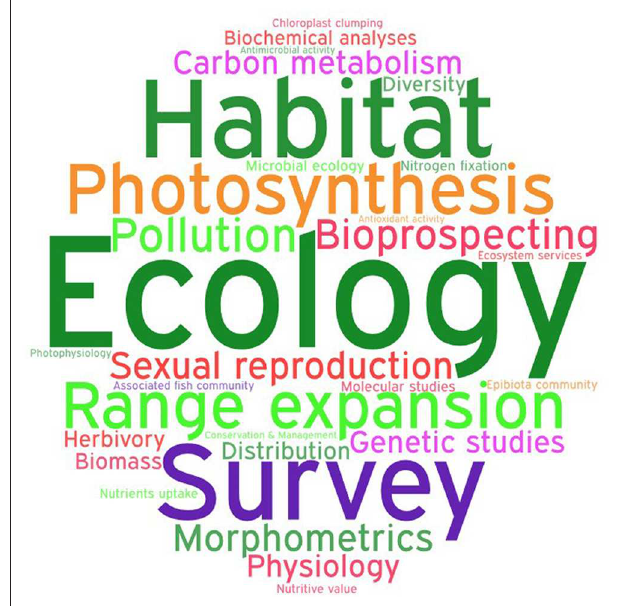
FIGURE 6 | Word cloud showing the diversity of the specific topics of research on Halophila stipulacea (category 2 in Table S1 , Figure 5B ). The size of each word indicates the relative frequency of the research